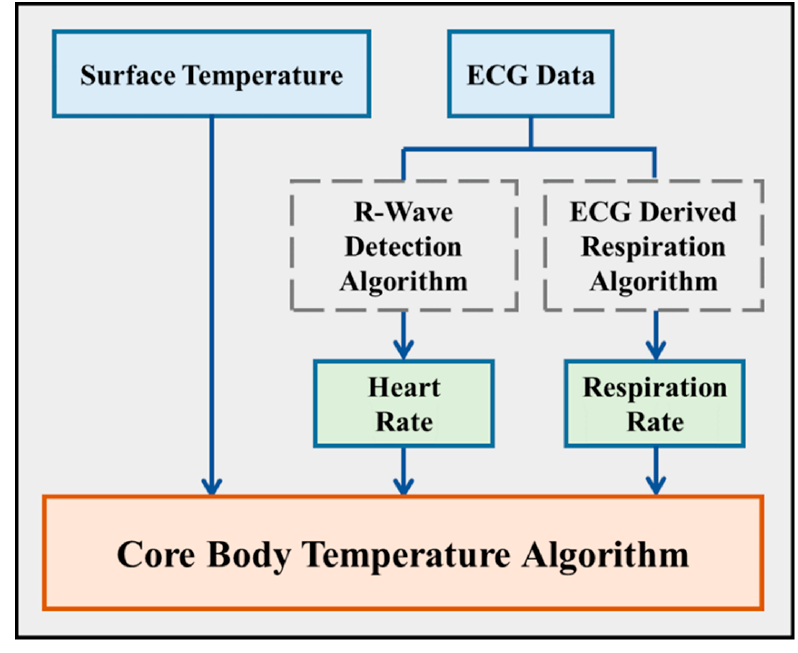
Figure 3. Block diagram of integrated intelligent algorithm. The raw ECG data were applied in two algorithms, R-wave detection algorithm and ECG-derived respiration algorithm, to derive HR and RR . Later, the values of HR , RR , and surface temperature were applied in a novel core body temperature algorithm to obtain human core body temperature.